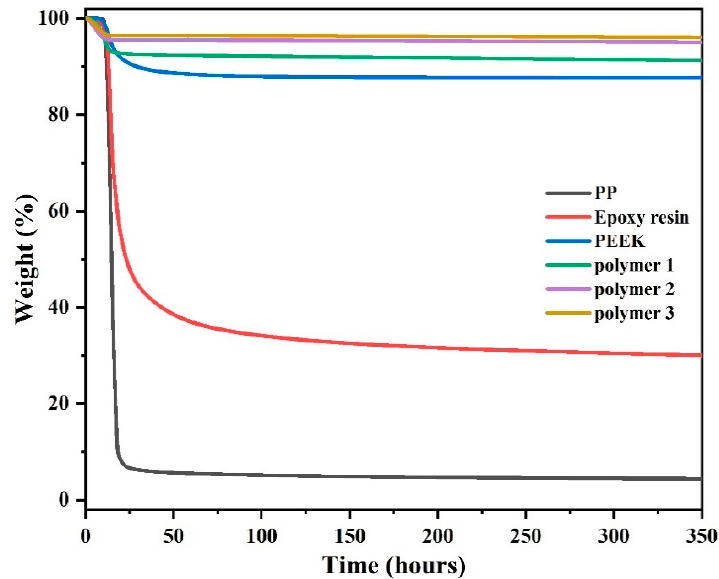
Figure 17. Long-term stability of five materials in an inert atmosphere at 300 °C.